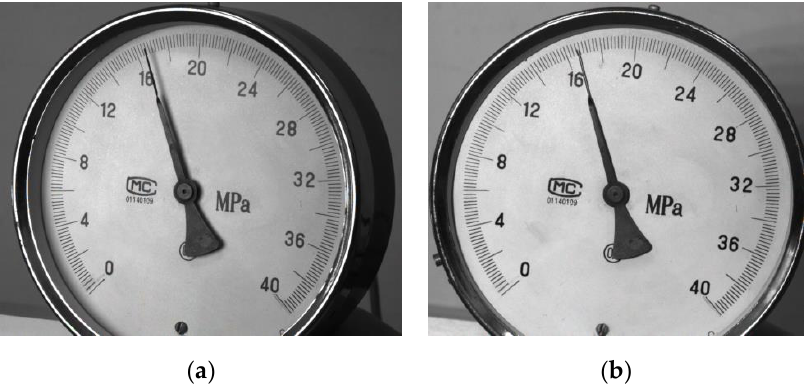
Figure 1. the distance between the each pointer meter and the camera is the same; ( a ) the pointer meter plane is facing the camera at an angle; ( b ) the pointer meter plane is facing the camera.